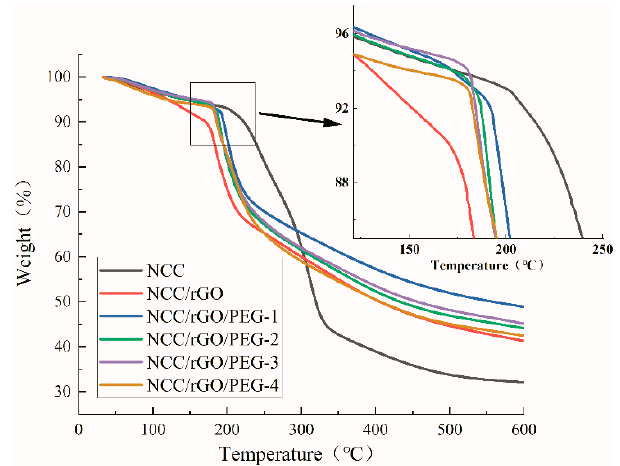
Figure 5. Thermalgravimetric analysis (TGA) of NCC film and its composite film.